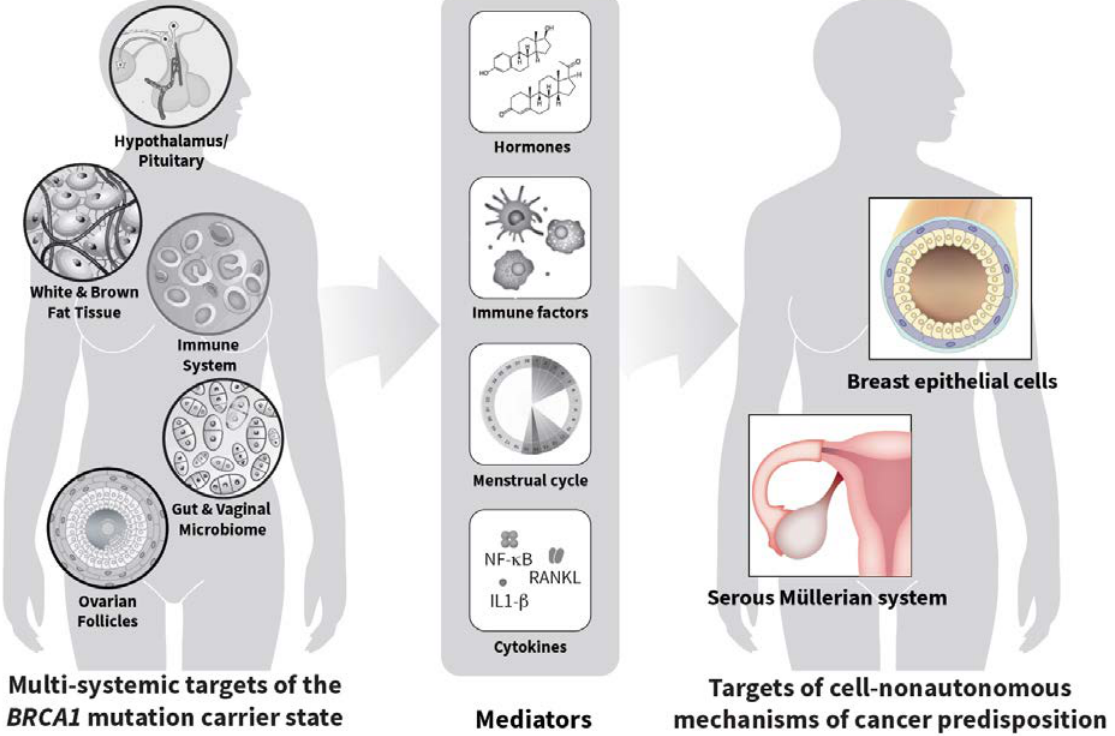
Figure 1. Cell-nonautonomous mechanisms of breast and ovarian cancer predisposition in BRCA1 mutation carriers. The diagram on the left illustrates various organs or systems other than those carrying an elevated cancer risk that are influenced by the BRCA1 mutation carrier state. These multi-systemic e ff ects lead to alterations in levels of hormones and cytokines such as those referred to as “mediators” in the figure. Such alterations interplay with cell-autonomous e ff ects of the BRCA1 mutation carrier state resulting in increased cancer risk in the organs shown on the right.